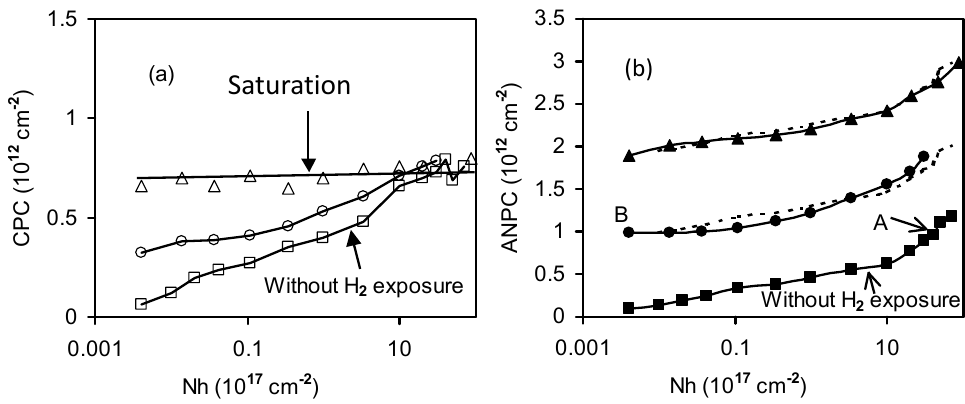
Figure 23. Impact of hydrogen exposure on CPC ( a ) and ANPC ( b ). The precursors for CPC are limited, and they can be converted to CPC by either electrical stress or hydrogen exposure. In contrast, the ANPC generated by electrical stress is not affected by the hydrogen exposure [54].